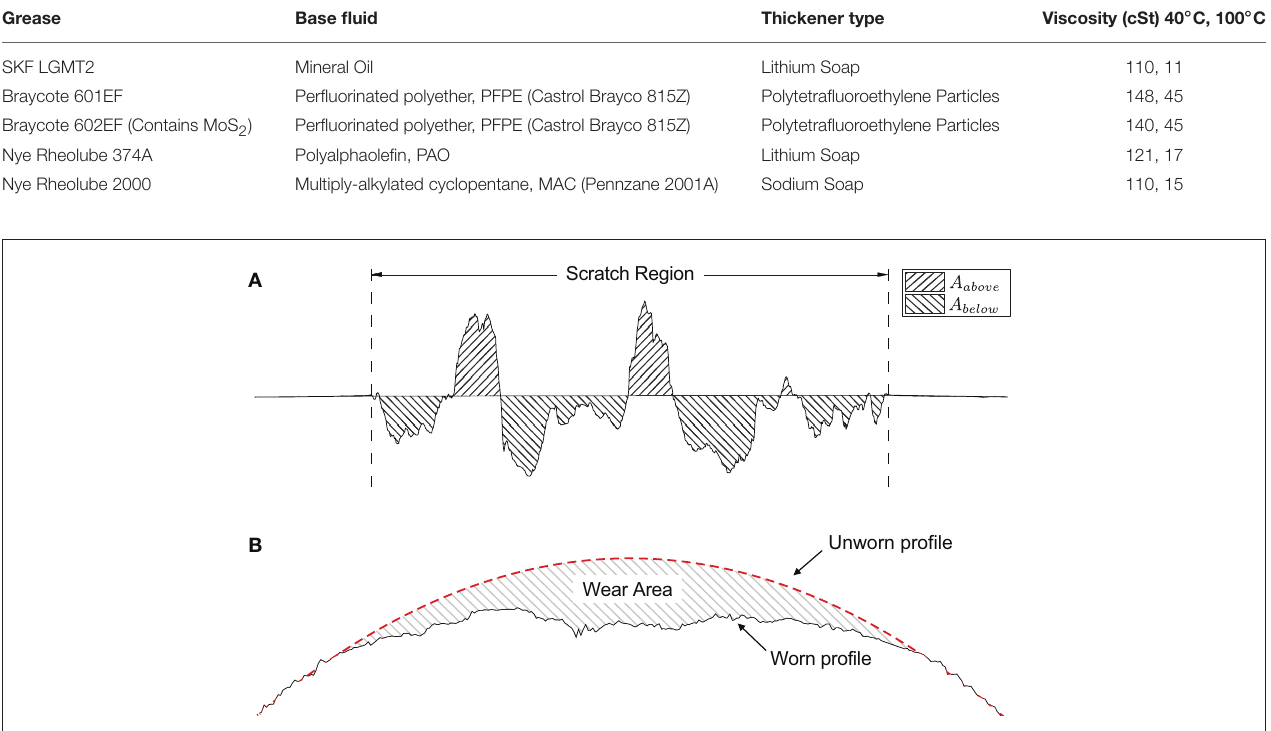
FIGURE 1 | Schematic diagrams illustrating the wear calculations for the flat (A) and the ball (B) samples.